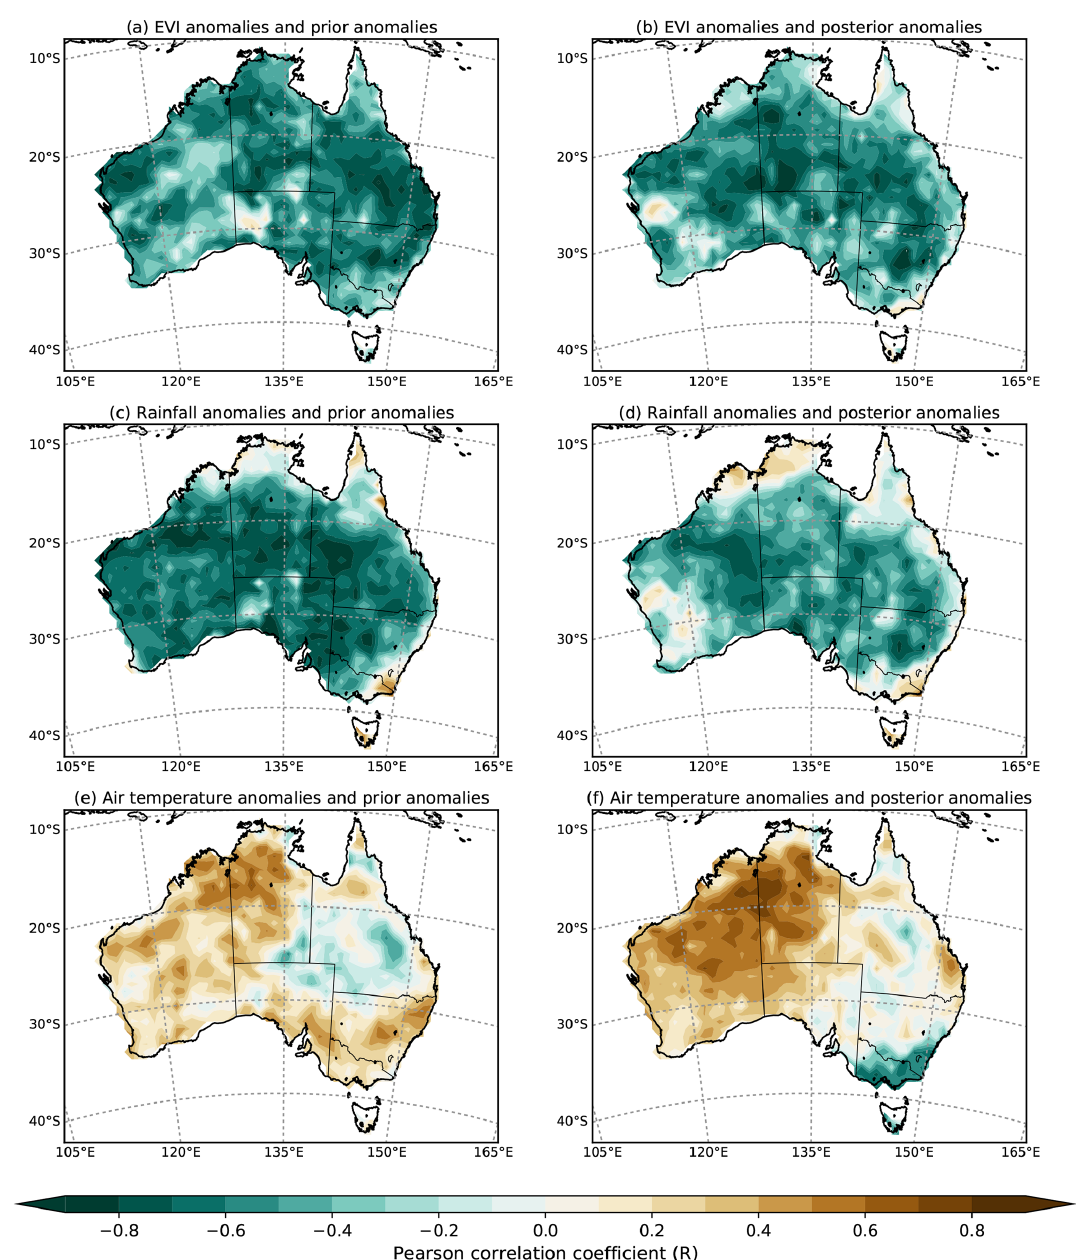
Figure 11. Spatial map of the monthly temporal correlation between (a, b) EVI prior and posterior anomalies, (c, d) rainfall prior and posterior anomalies, and (e, c) air temperature prior and posterior anomalies for the 2015–2019